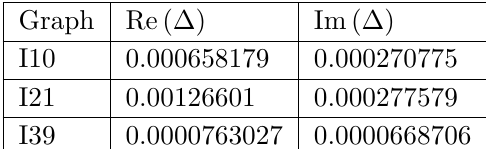
Table 4 . The mean di(cid:11)erence (cid:1) between TayInt and SecDec , normalised to the SecDec result. The kinematic points are u 2 [4 m 2